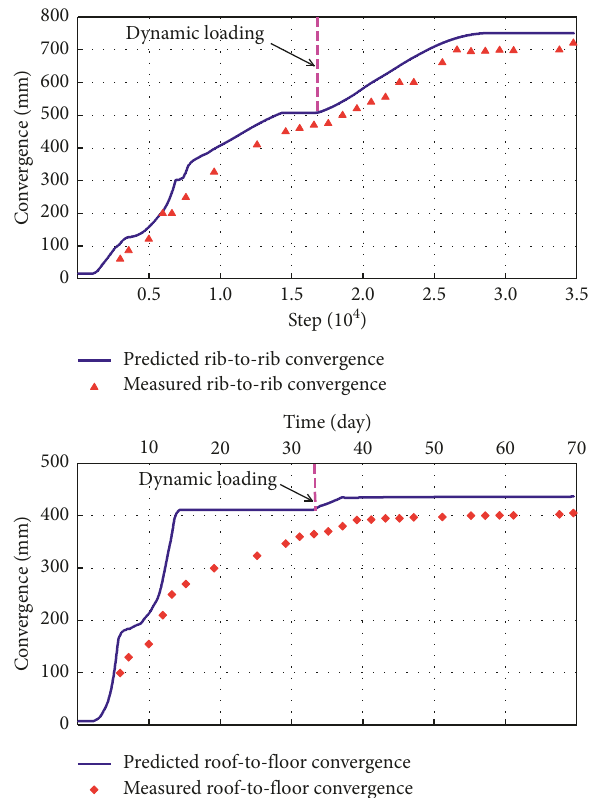
Figure 12: Comparison of the predicted and measured entry